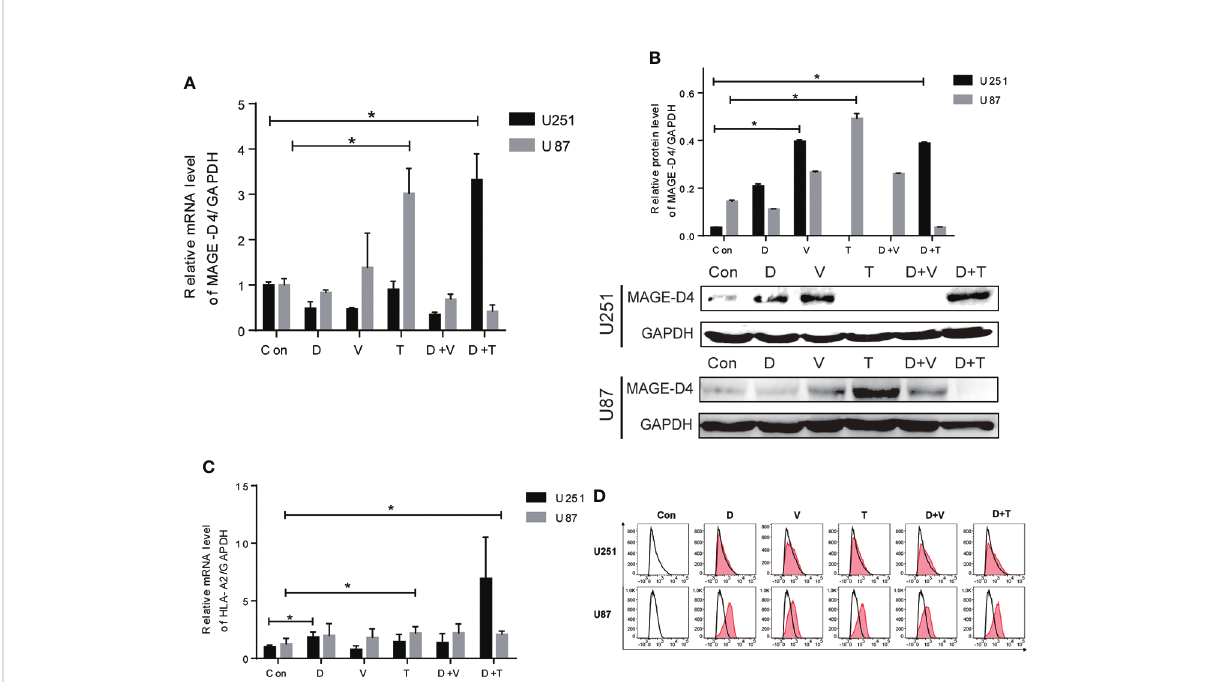
FIGURE 2 Expression of MAGE-D4 and HLA-A2 in glioma cells treated with epigenectic drugs. (A) Relative mRNA expression of MAGE-D4 in U251 and U87 cells treated with epigenectic drugs. (B) Relative mRNA expression of HLA-A2 in U251 and U87 cells treated with epigenectic drugs. (C) Relative protein expression of MAGE-D4 in U251 and U87 cells treated with epigenetic drugs. (D) Expression of HLA-A2 in U251 and U87 cells treated with epigenetic drugs. Con, control; D, DAC; V, VPA; T, TSA; D + V, DAC + VPA; D + T, DAC + TSA; *P